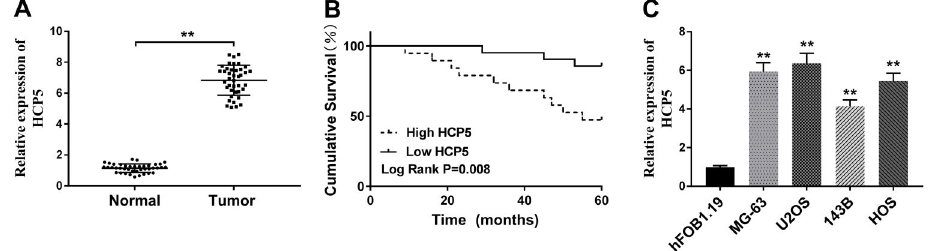
Figure 1. HCP5 was highly expressed in osteosarcoma (OS) tissues and cell lines. A , QRT-PCR assay was performed to measure the expression of HCP5 in 40 pairs of OS tissues and adjacent normal tissues. B , The cumulative survival of OS patients with high HCP5 (n=19) expression or low HCP5 (n=21) expression was recorded. C , Relative expression of HCP5 in different OS cell lines and human osteoblast cell hFOB 1.19 was detected by qRT-PCR. Data are reported as means ± SD. ** P o 0.01 (Student ’ s t -test and ANOVA).